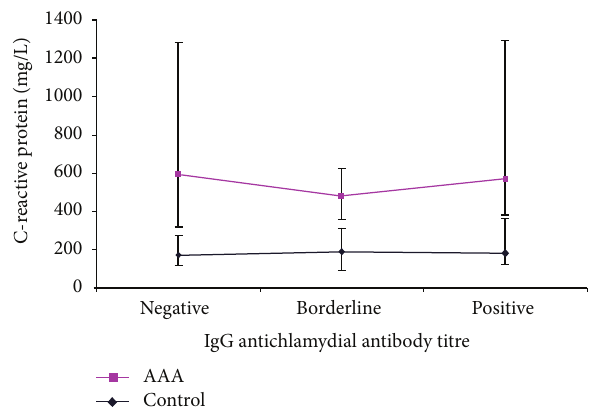
Figure 3: C-reactive protein in control versus AAA groups at different IgG anti chlamydial antibody titres: negative ( 𝑃 = 0.003 ), borderline ( 𝑃 = 0.055 ), and positive ( 𝑃 = 0.0001 ) expressed as median and IQR (Mann-Whitney 𝑈